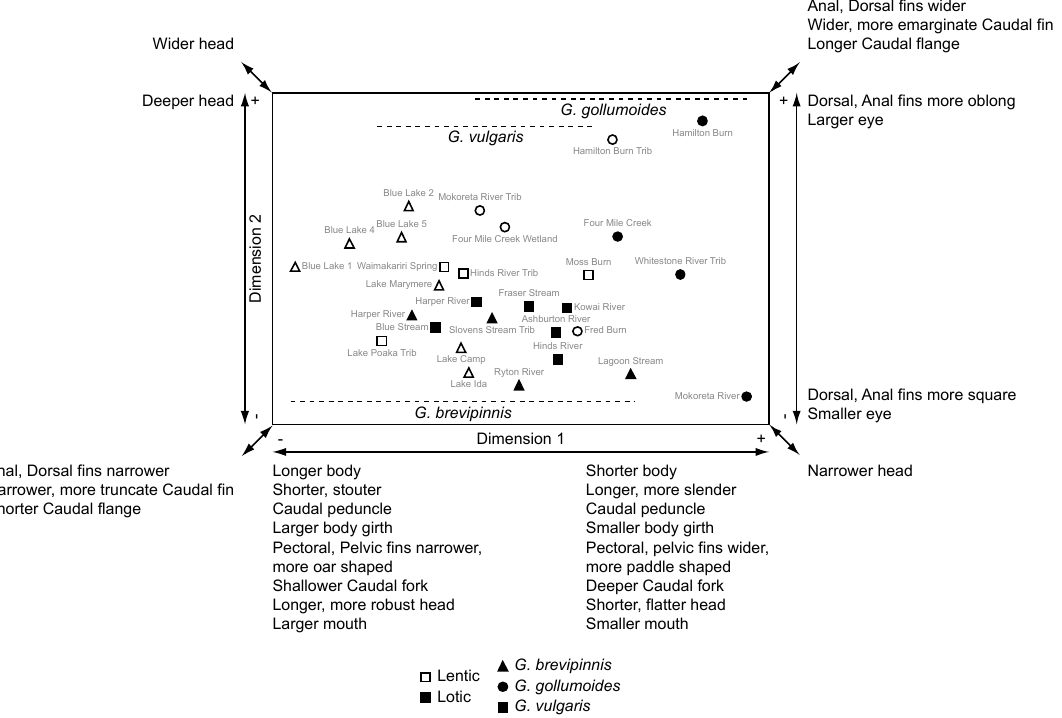
Figure 4. Morphological multidimensional scaling (MDS) ordination of fifty-three mean relativised standard length standardised G. brevipinnis , G. gollumoides and G. vulgaris morphological variables from twenty-nine habitats. Descriptors are interpreted from Spearman ρ correlations of morphological variables and dimension scores significant at p < 0.05 (Table 3). Arrows indicate negative and positive directions across dimensions. Diagonal arrows indicate significant correlations of variables with both dimensions. Spread across dimension 1 for each species is given by dashed lines.